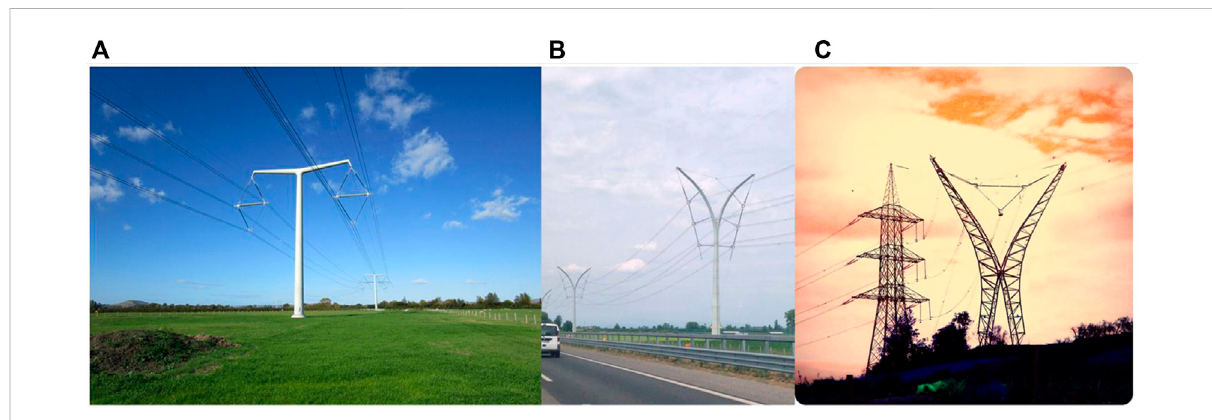
FIGURE 1 (A) T-pylon (Photo credits: Jonathan Thacker, “ Grassland and T pylons ” , licensed under the Creative Commons Attribution-ShareAlike 2.0 Generic (CC BY-SA 2.0), Available online: https://www.geograph.org.uk/photo/7309807); (B) Germoglio pylon (Photo credits: Andreas Karrer, “ Freileitungsmast-Italien ” , licensed under the Creative Commons Attribution-Share Alike 4.0 International license. Available online: https:// commons.wikimedia.org/wiki/File:Freileitungsmast-Italien.jpg); (C) Fosterpylon(Photocredits:Giagir, “ LuieLeiElettrici ” ,forkindpermissionof Giagir, Available online: https://www. fl